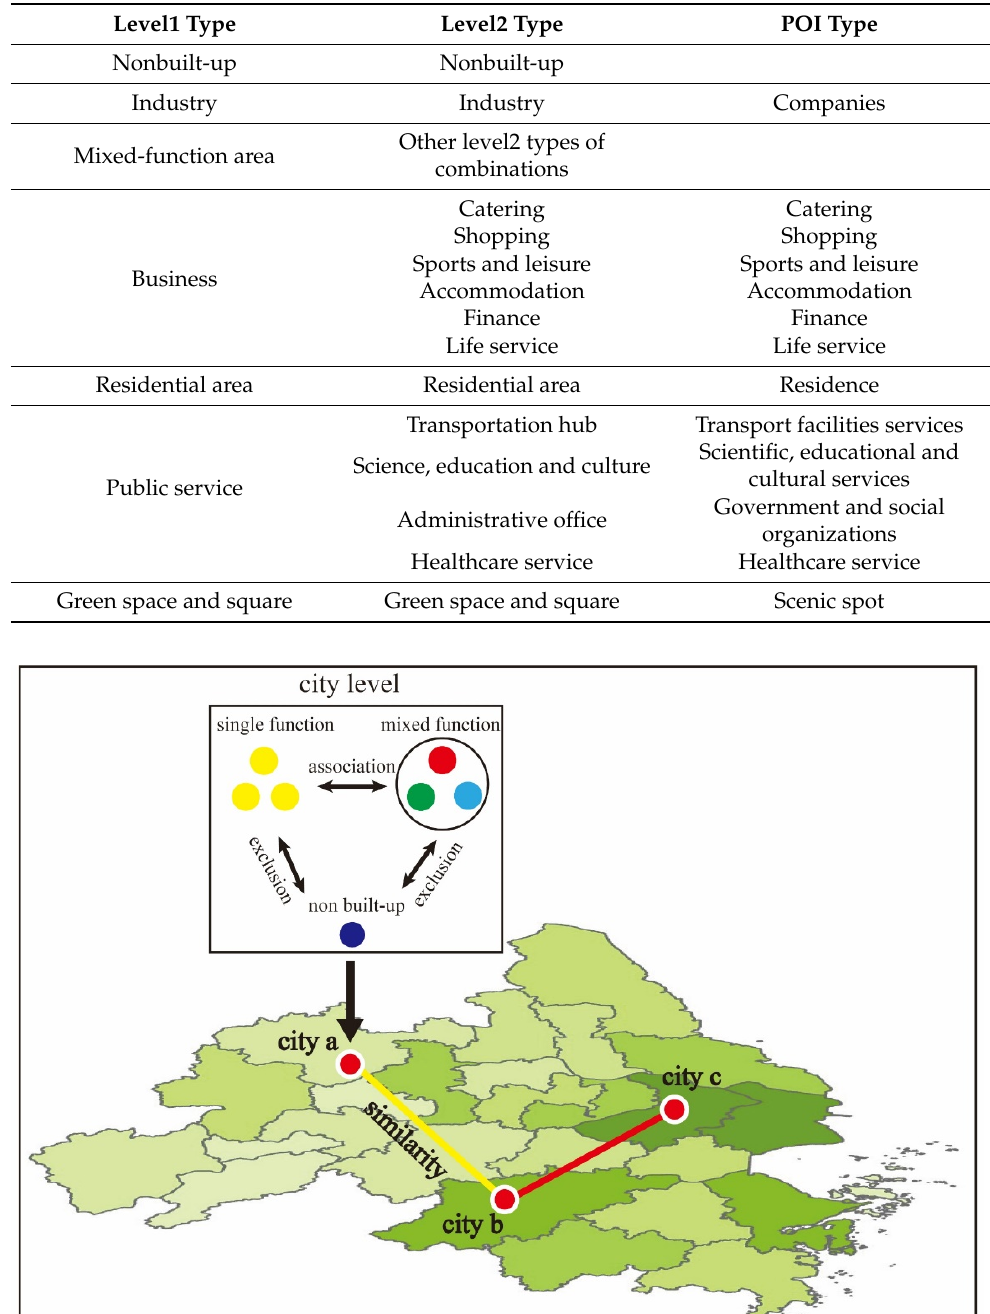
Table 1. Classification of functional areas.